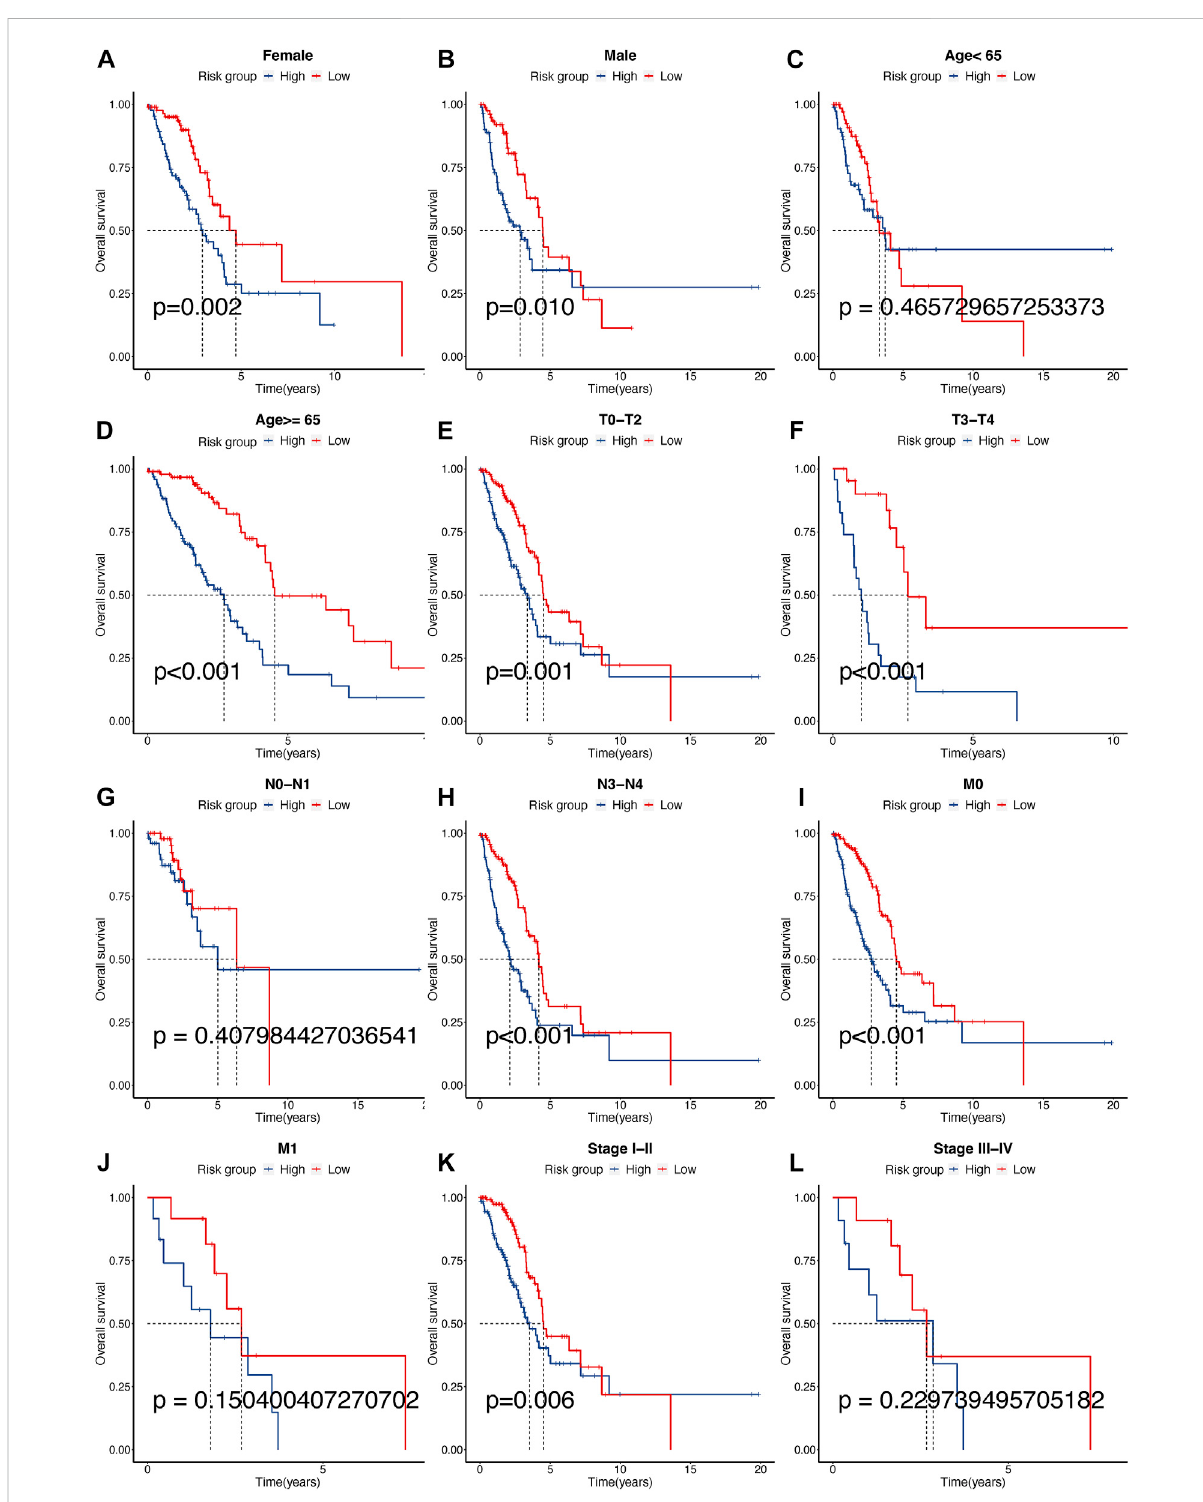
FIGURE 10 Differentclinicalsub-groupsurvivalanalysesbetweenhigh-andlow-riskgroupsintheTCGA-LUAD cohort. (A – L) KManalysisbetweengender (Female: a,Male:b),age( < 65:c, ≥ 65:d),T(TX-T2:e,T3-T4:f),N(N0-N1:g,N2-N3:h),M(M0:i,M1:j),andstage(I-II:k,III-IV: l)forhigh-andlow-risk scores in TCGA-LUAD